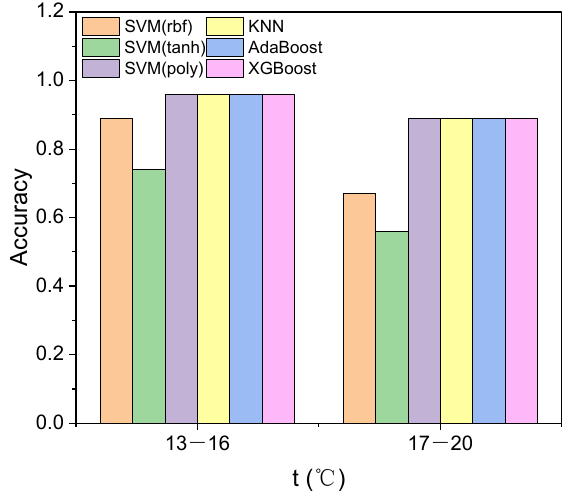
Figure 10. The accuracy of models in terms of the temperature of exposure situations.